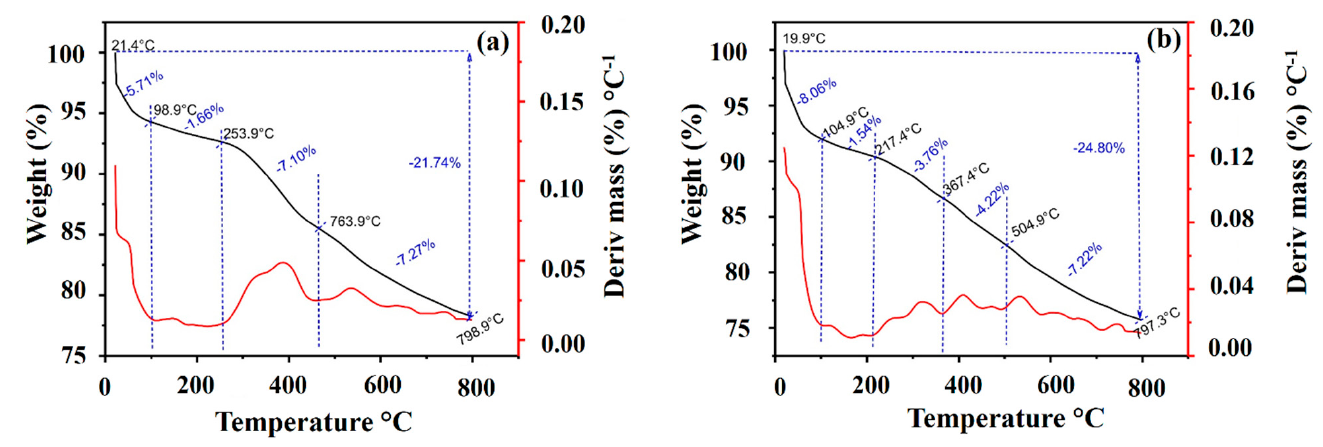
Figure 4. TGA and DTG curves of ( a ) MAC1105 and ( b ) MAC111.